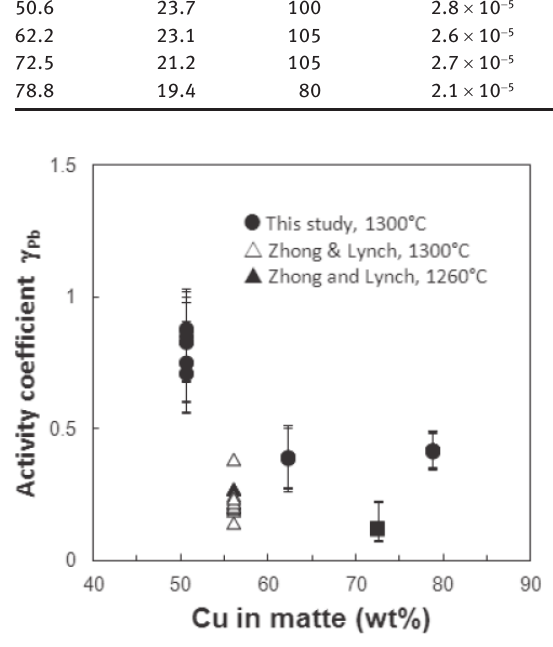
Fig. 8: Calculated activity coefficient of Pb with respect to Pb ( g ) as a function of matte grade from this study at 1300 °C, and compared with that from the results of Zhong and Lynch [8].